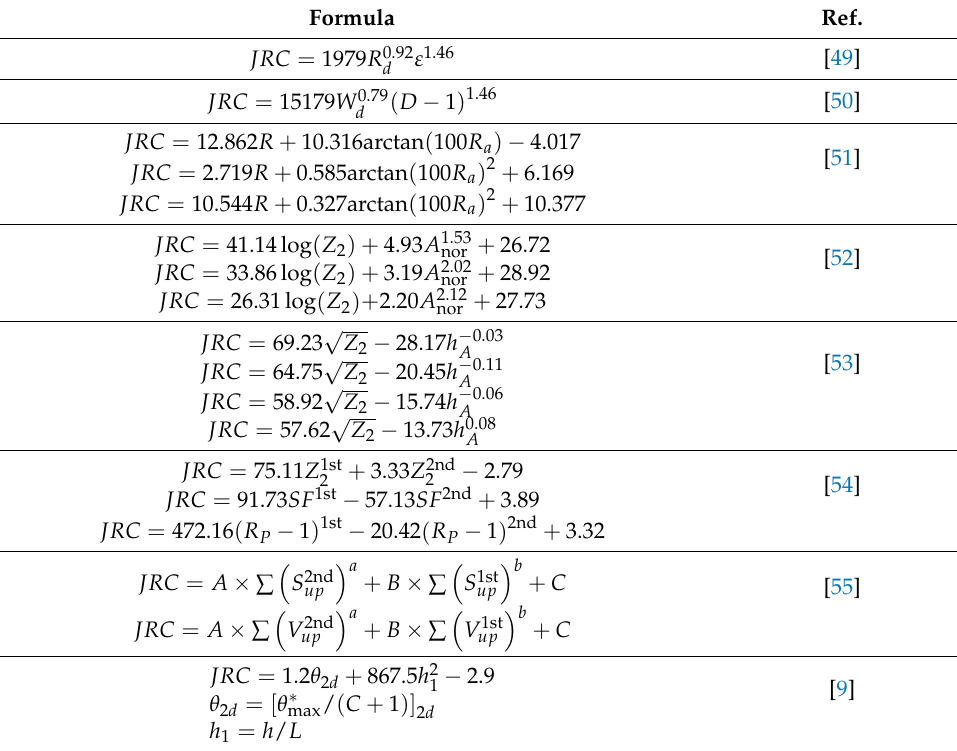
Table 2. The characterization formula by two statistical parameters. Formula